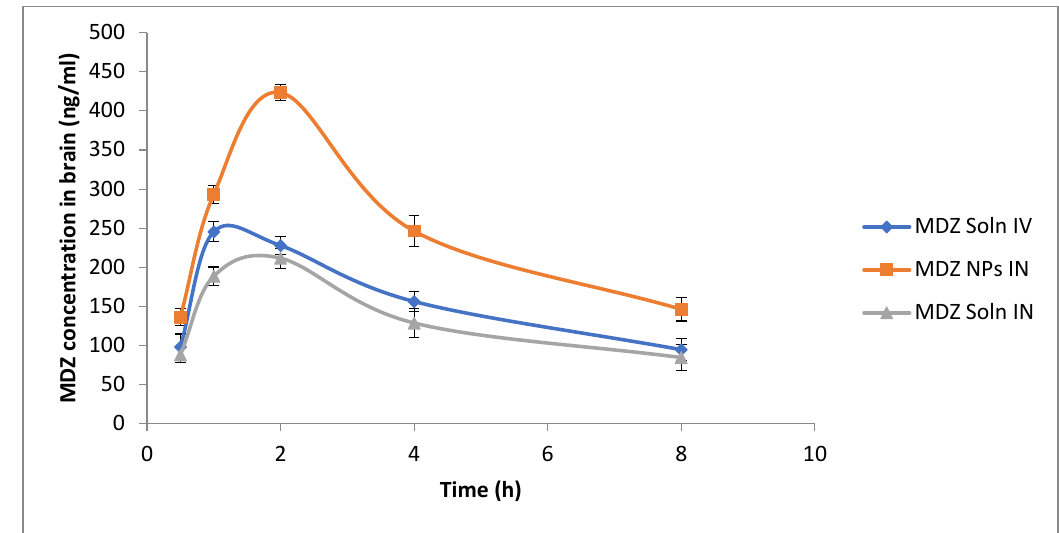
Figure 6. Graph of MDZ concentration in brain homogenate at different time intervals following MDZ solution IV, MDZ solution IN, and MDZ CS NPs IN administration ( n = 3, mean ± S.D.)